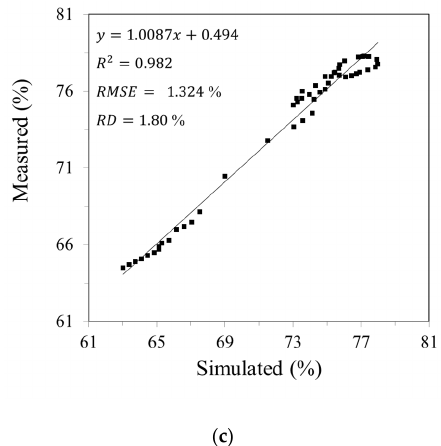
Figure 10. Results of linear regression for the measured and simulated power transmission efficiency based on the gear stages: ( a ) first gear stage; ( b ) second gear stage; ( c ) third gear stage.